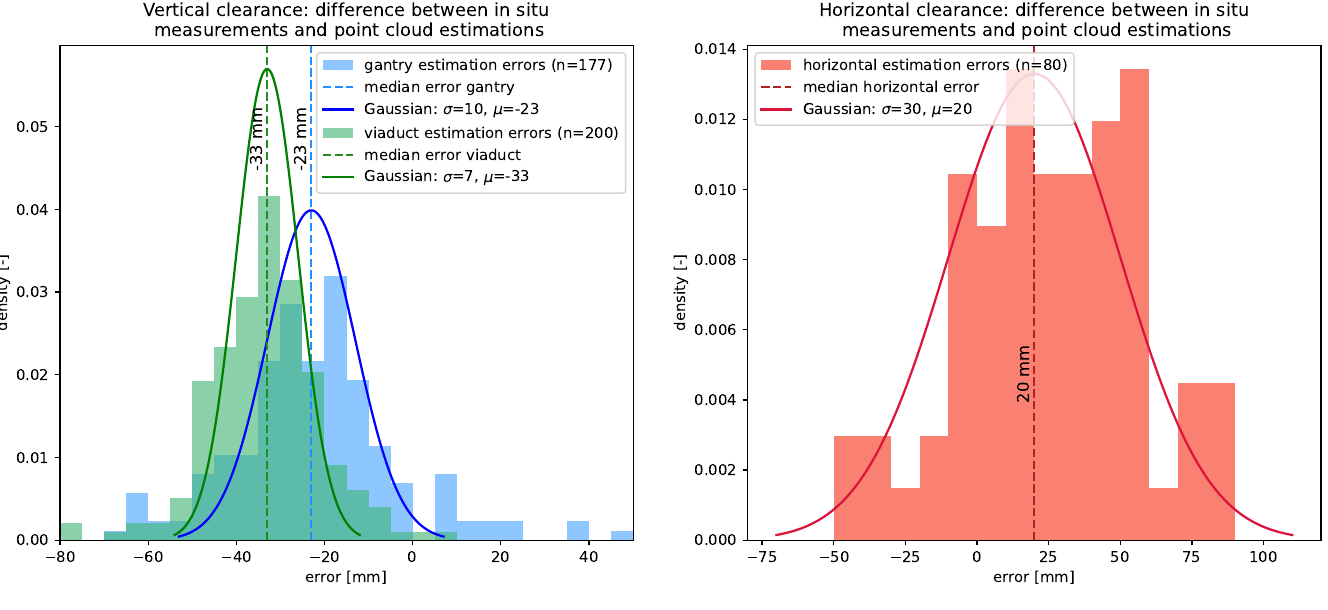
Figure 10. Histogram of errors of the estimated